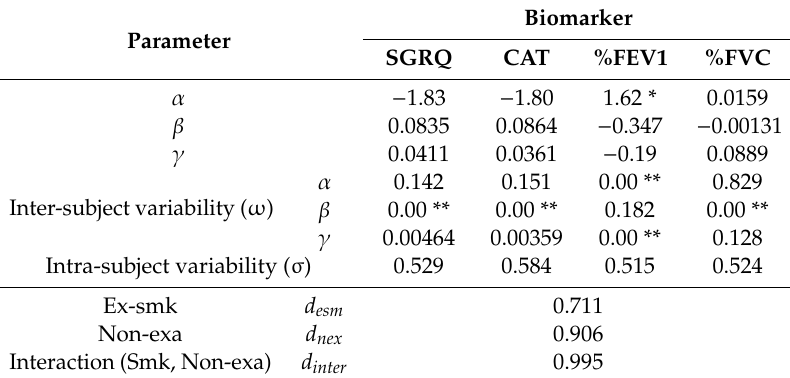
COPD: Chronic obstructive pulmonary disease , SReFT: Statistical Restoration of Fragmented Time- course, SGRQ: St. George’s Respiratory Questionnaire, CAT: Chronic obstructive pulmonary disease